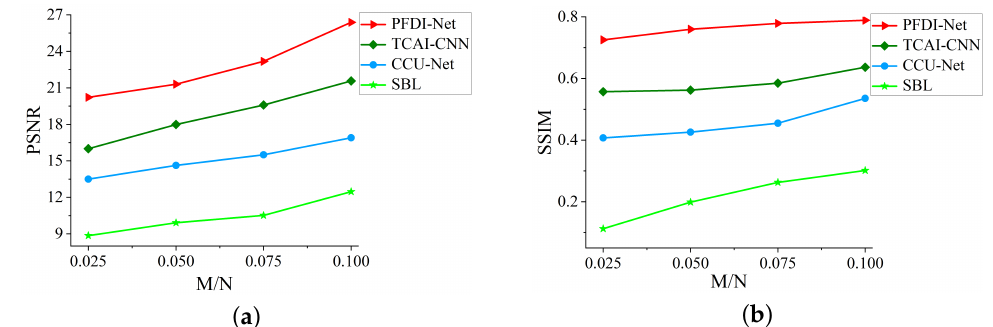
Figure 7. PFDI-MNIST: Imaging results in two imaging algorithm with different scene information sampling ratio. ( a ) PSNR performance. ( b ) SSIM performance.